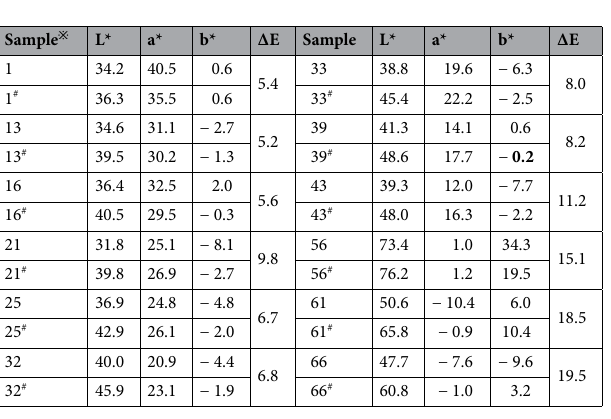
Table 5. Color difference of dyed wool yarns before and after light colorfastness